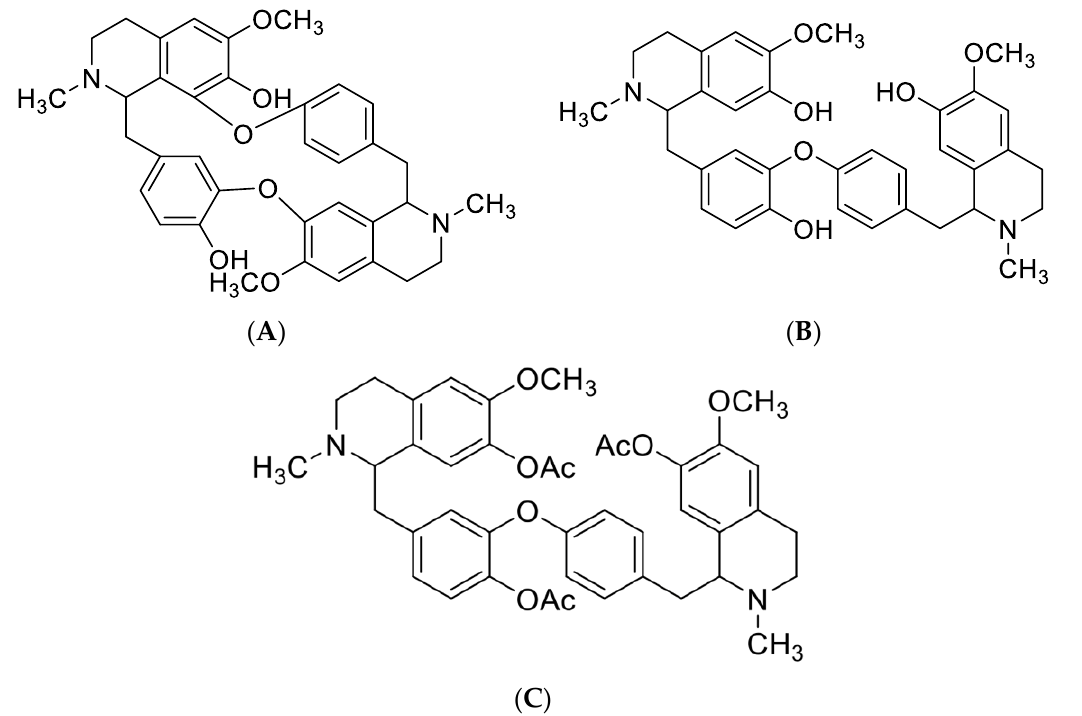
Figure 1. Chemical structures of compounds isolated from the roots of Isolona hexaloba: curine ( A ), guattegaumerine ( B ), and triacetylguattegaumerine ( C ).